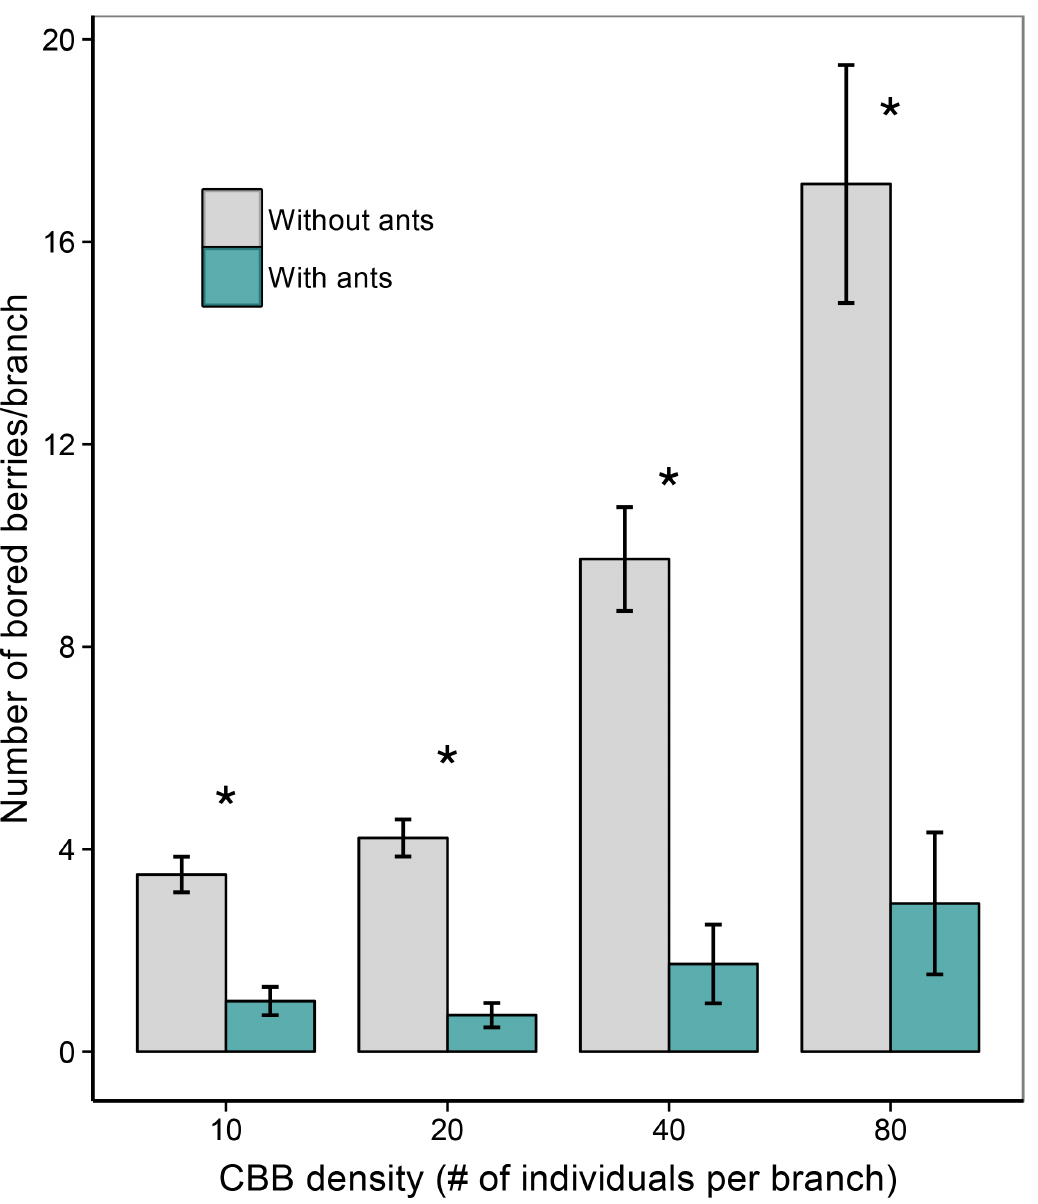
Fig 3. Coffee berry borer (CBB) infestation. Bars show the mean number of bored berries per branch ( ± SE) in the presence and absence of Azteca sericeasur at each CBB density treatment after 24 hours. Statistically significant differences in infestation between branches with and without ants are marked, where * = p <